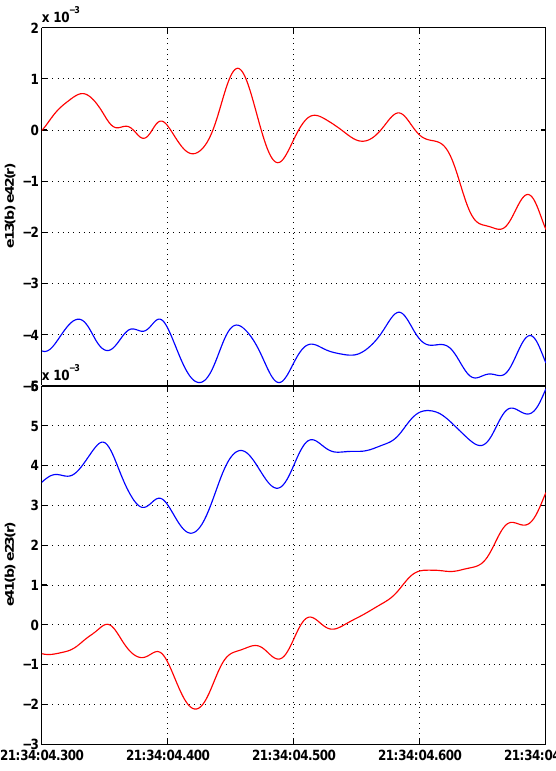
Fig. 8. The ω − k joint spectrum calculated from the two parallel electric field components E 41 and E 23 for event 2.